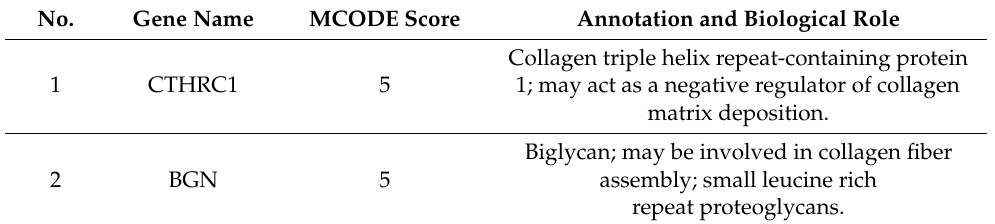
Table 2. Hub genes selected by Cytoscape MCODE score and their biological role.